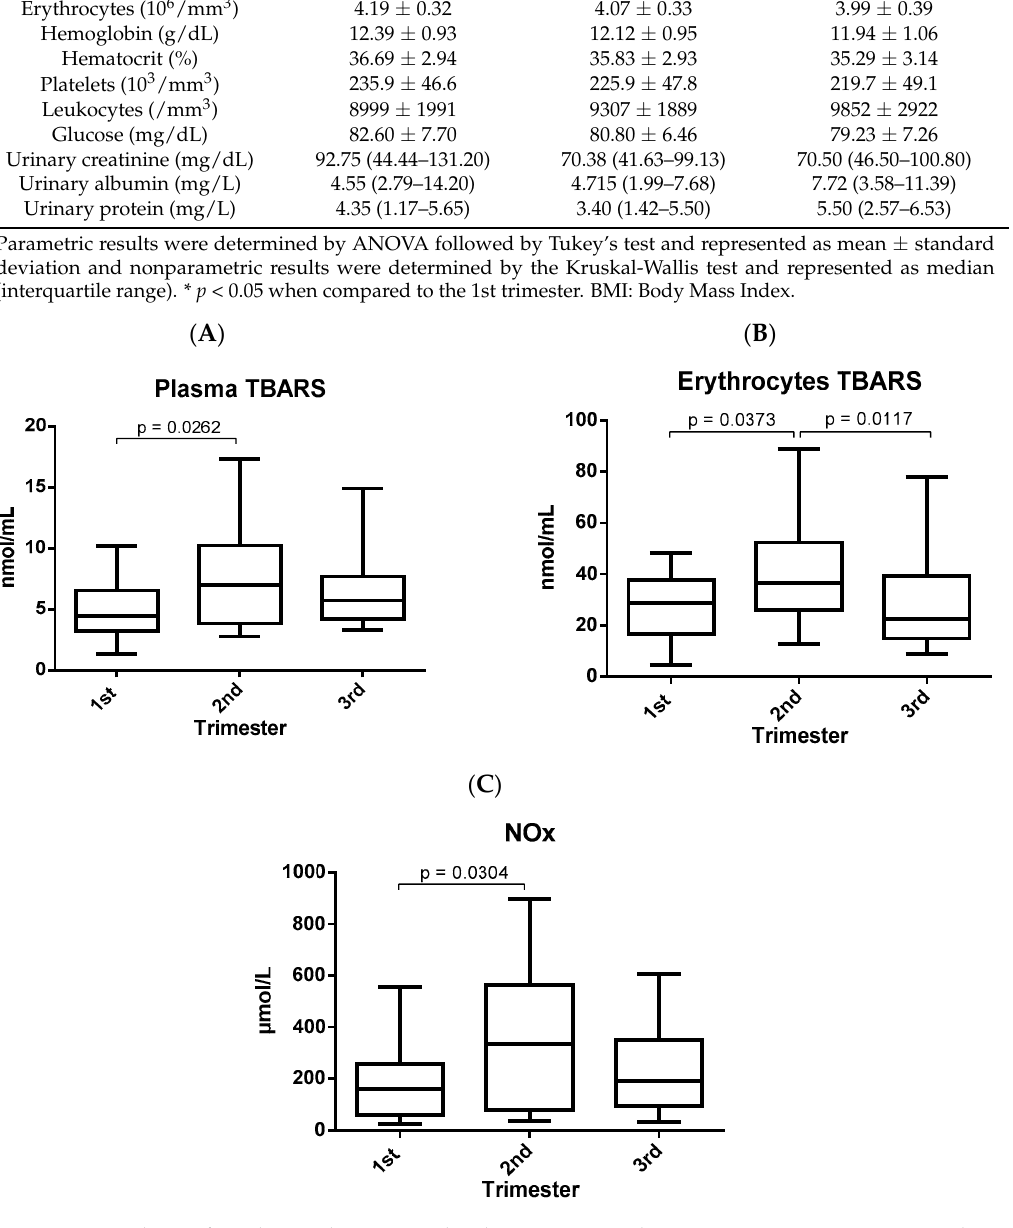
Table 1. Clinical and demographic characteristics in pregnant women in the three gestational trimesters.